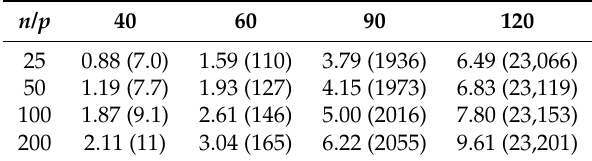
Table 1. Running time of the proposed test and direct estimator (in